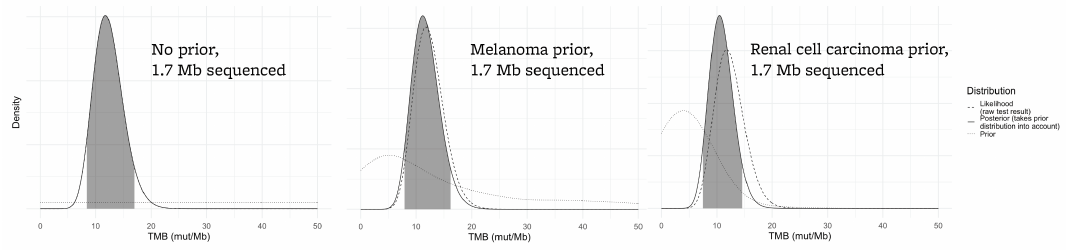
Figure 5. For a larger assay sequencing 1.7 Mb, the effect of the prior distribution on the “true” TMB result is less marked. All panels assume an assay-generated TMB value of 12 mut/Mb.